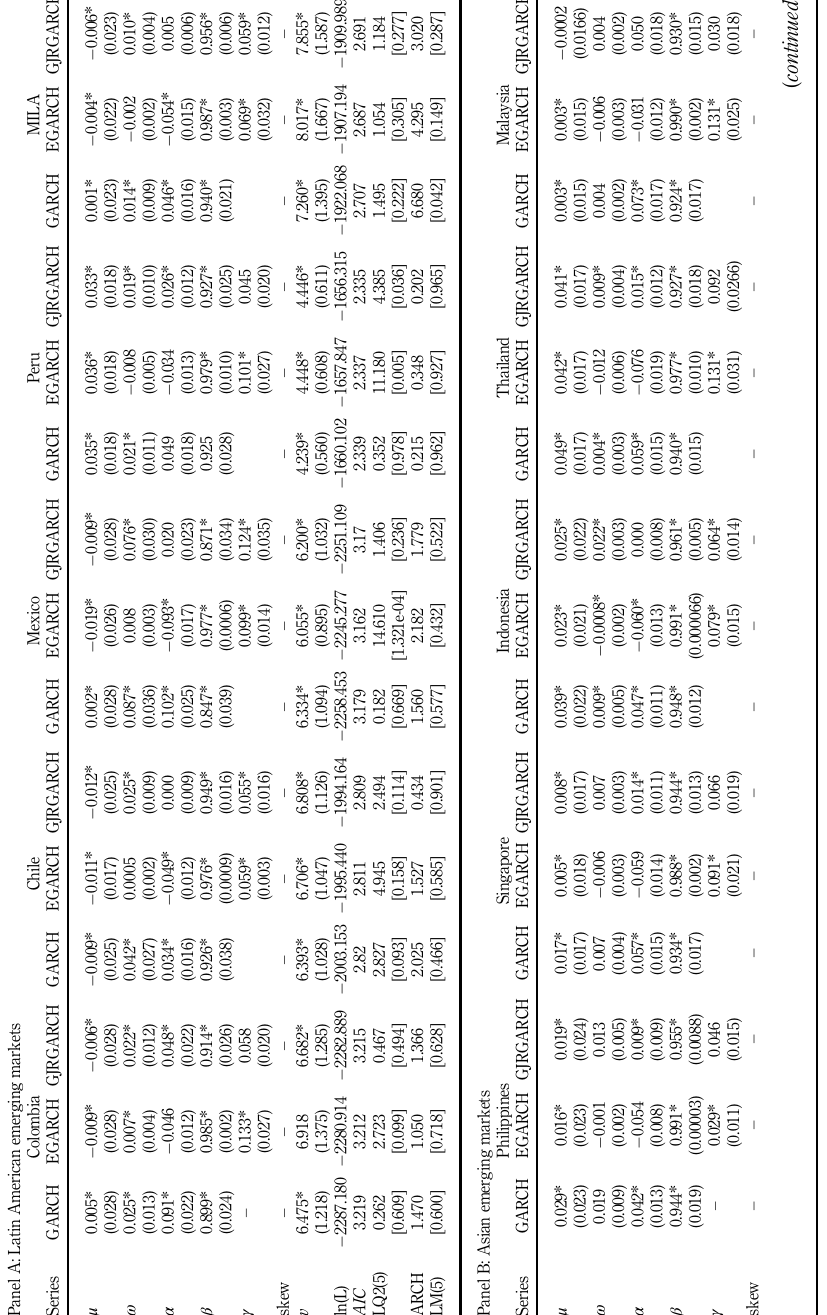
Table 4. Estimation results